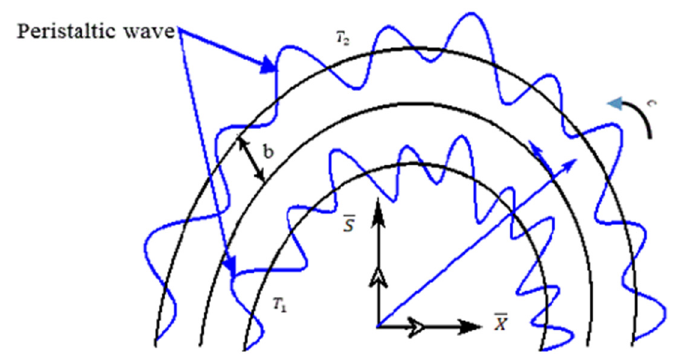
Figure 1. Flow illustration of model.